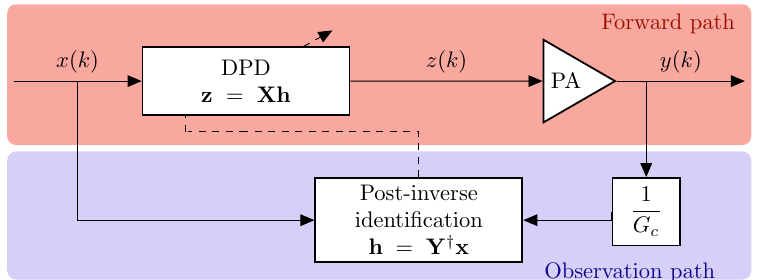
Figure 8. Block diagram of the employed indirect learning architecture